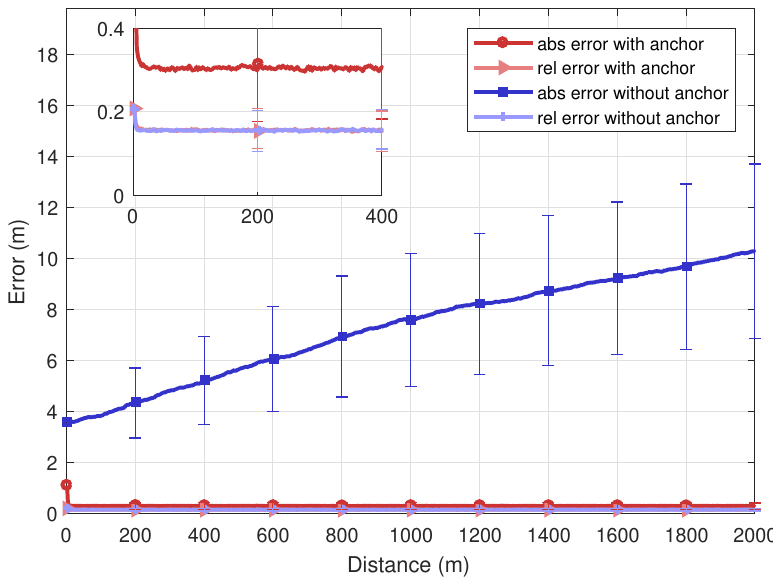
Figure 7. Error of SMP: with and without an